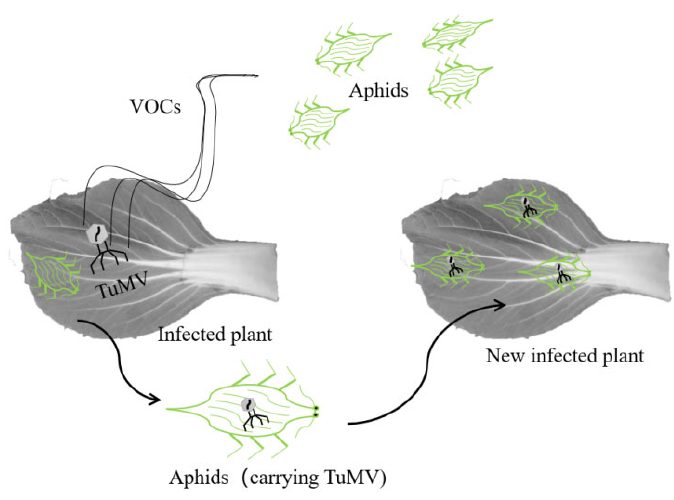
Figure 1. The mode of TuMV transmission in brassica crops by